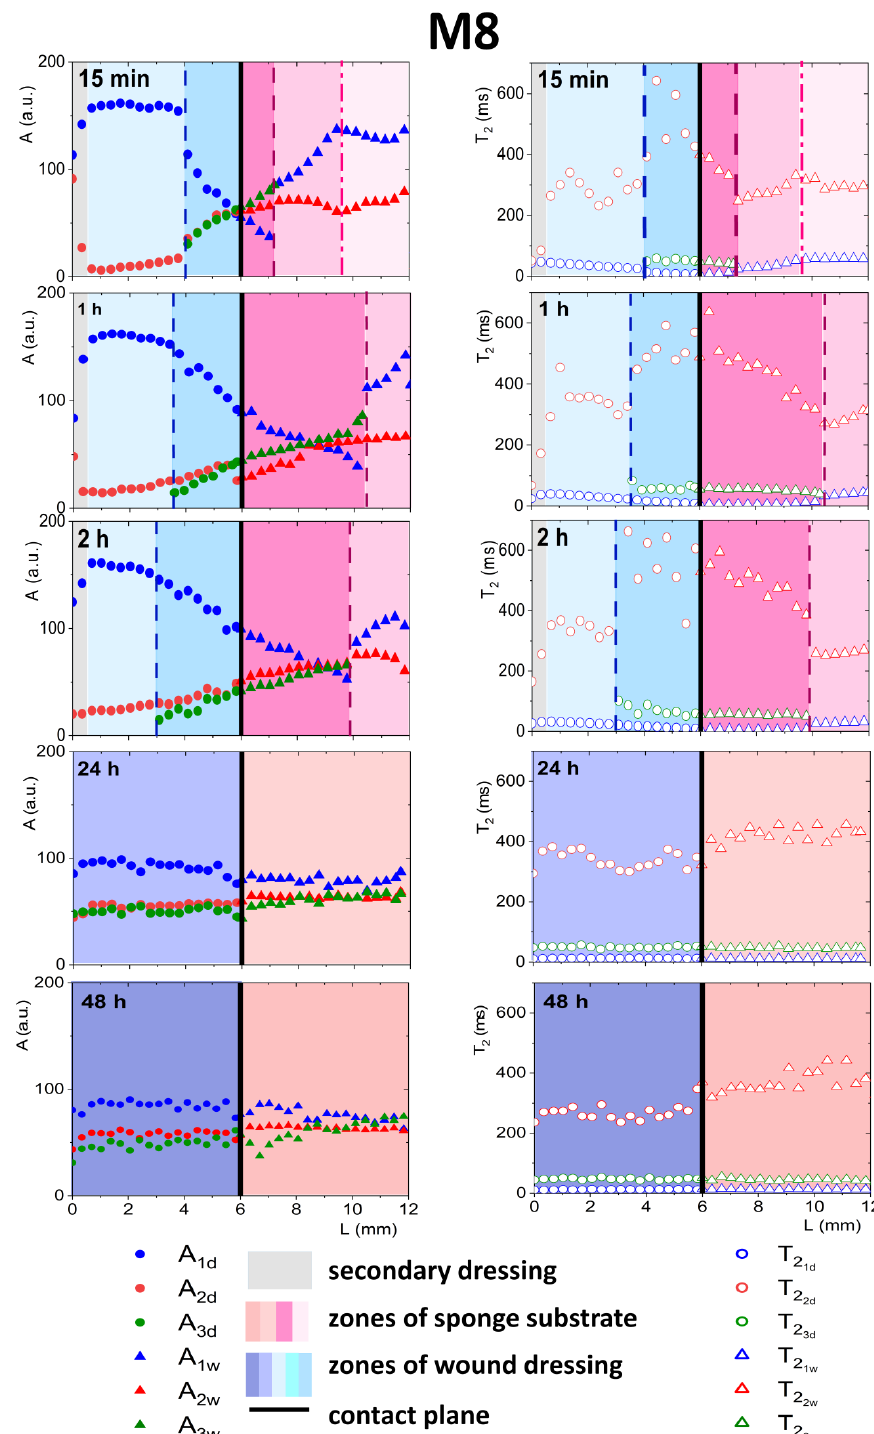
Figure 6. Parameter profiles obtained by MRI, relaxation time ( T 2 ) or signal amplitude ( A ), for M8 for the whole in vitro wound dressing stack model, when the sponge medium solution was PG.